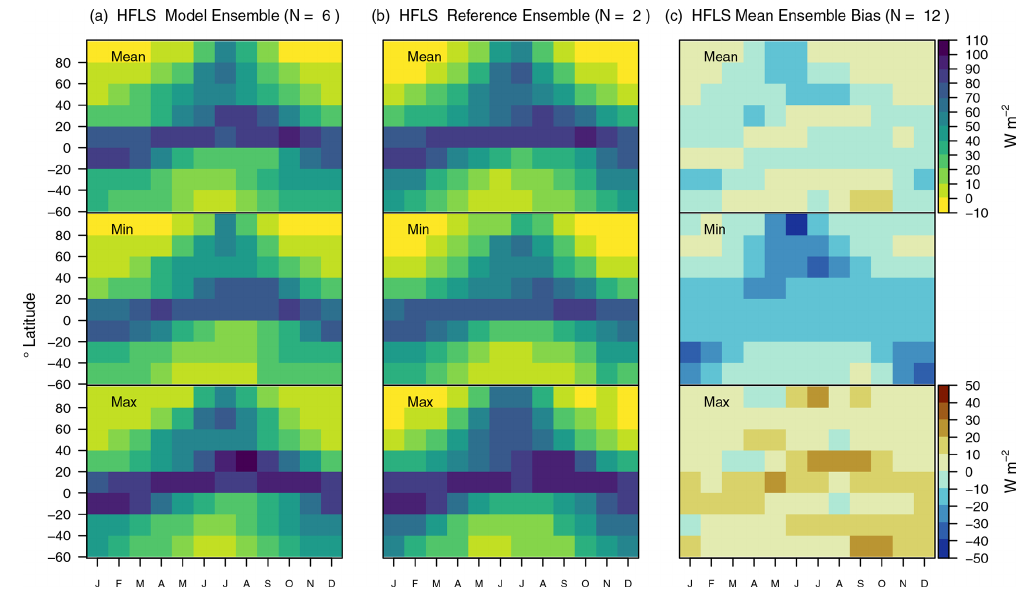
Figure A10. Same as in Fig. 8 but for latent heat flux.